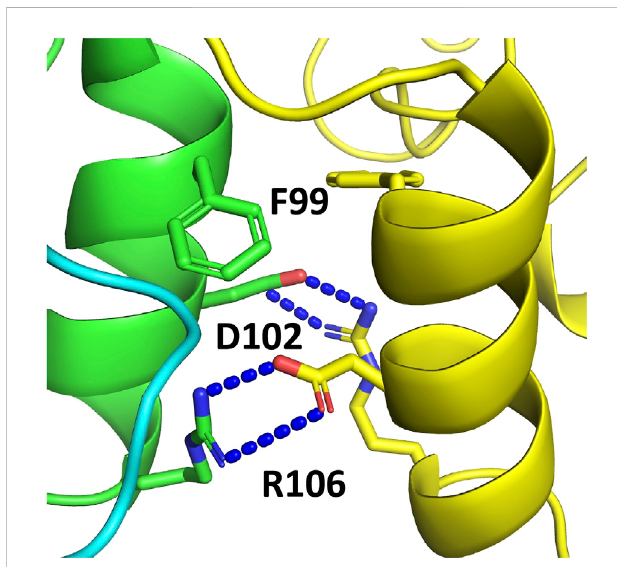
FIGURE 9 AlphaFold prediction of the dimerization interface of the SIRPT1 HSP-NRD domain of sacsin. The interface is clearly modelled on thedimerizationoftheN-terminaldomainsofHsp90.Residesimportant in the dimerization of the HSP-NRDs are shown in stick